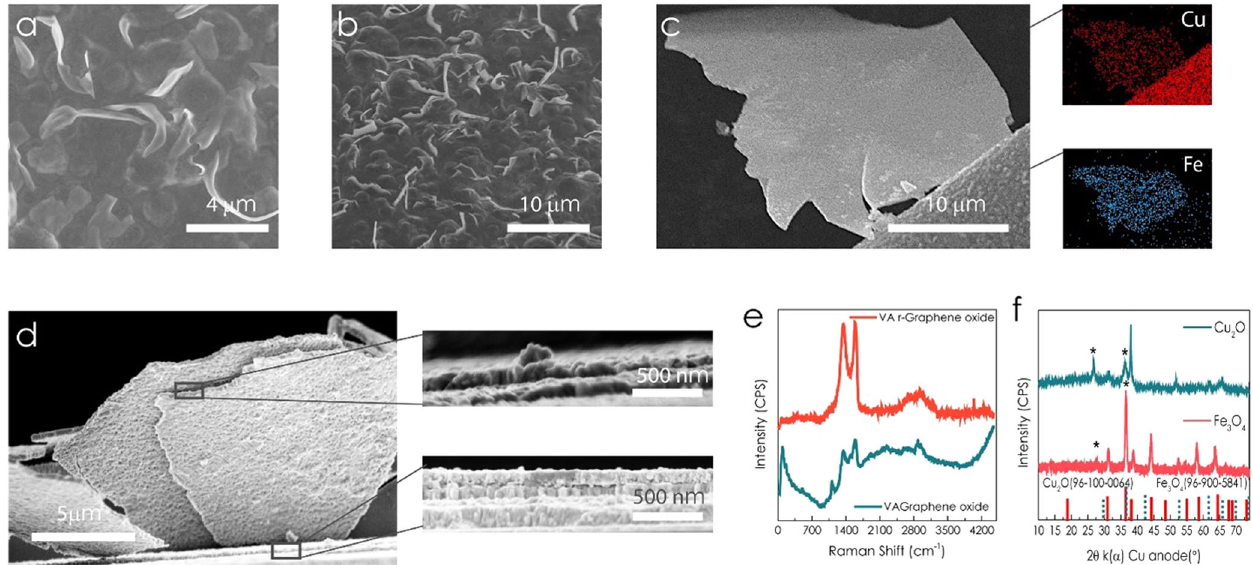
Fig. 2 Morphological characteristics of vertically aligned rGO Fe 3 O 4 and Cu 2 O composites. SEM image of the a vertically aligned rGO scaffold after deposition of the 100 nm Fe 3 O 4 fi lm and b after subsequent Cu 2 O deposition. c SEM image corresponding to a detached single fi lms. Outsets: EDS mapping of the Fe and Cu from the fl ake of the rGO sheets on a copper grid conformally covered with Fe 3 O 4 and Cu 2 O Fe 3 O 4 /Cu 2 O deposited fi lms on the rGO fl ake. d Tilted view of the hybrid composite structure. The outset SEM images magn fi y the conformal coverage of the rGO fl akes and the substrate with a dual layer of Fe 3 O 4 and Cu 2 O fi lms. e Raman spectra corresponding to ultra-high